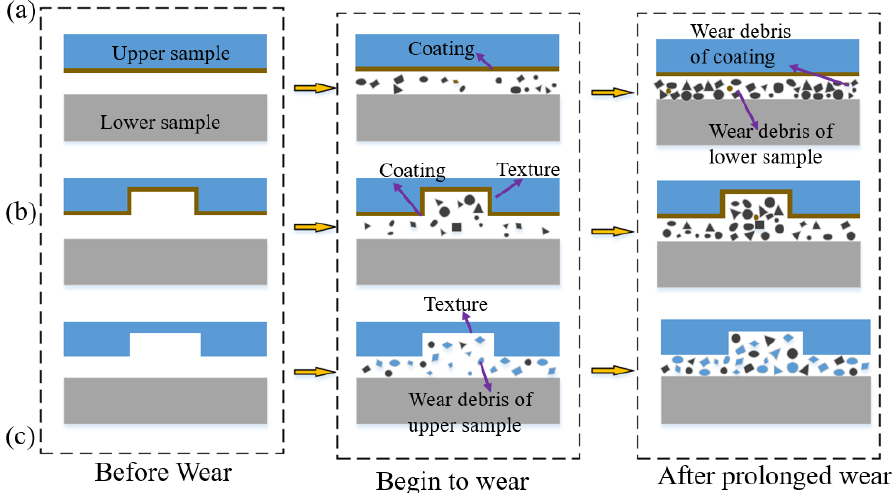
Figure 10. Schematics of the wear. ( a ) Wear schematic diagram of the coated sample; ( b ) wear schematic diagram of the textured and coated sample; ( c ) wear schematic diagram of the textured sample.